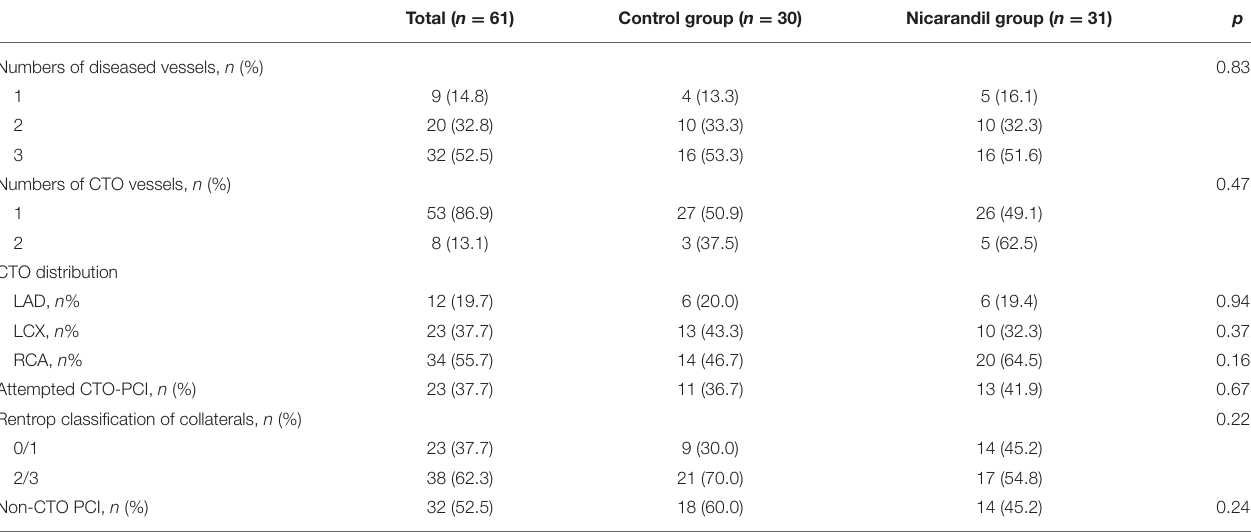
TABLE 2 | Baseline angiographic and procedural characteristics of the nicorandil group and the control group. Total ( n = 61) Control group ( n = 30) Nicarandil group ( n = 31) p